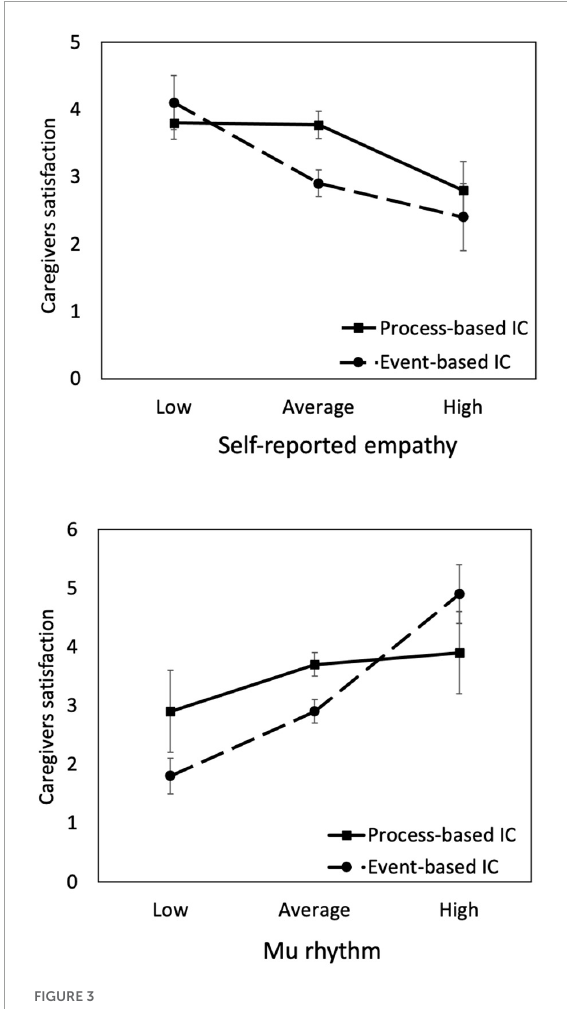
FIGURE3 Interactions between empathy (represented by self-reported empathy and mu rhythm) and physician–patient communication style (process-based vs. event-based IC). The negative effect of empathy on caregivers satisfaction is more substantial in the event-IC than process-IC condition. The levels of empathy are plotted at M – SD (low), M (average), and M + SD (high).